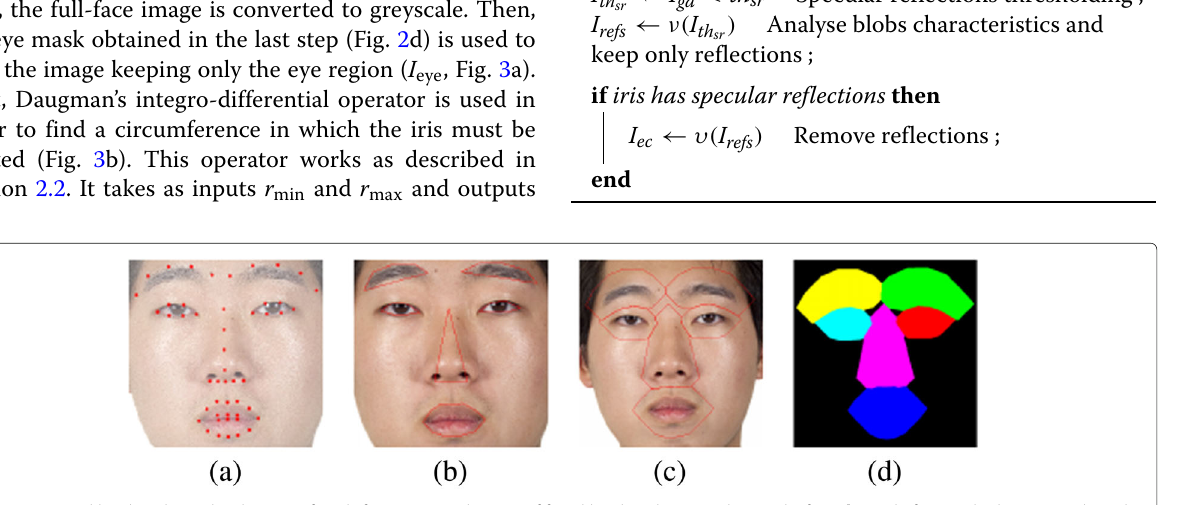
Fig. 2 Detected landmarks and polygons of each feature. Distribution of facial landmarks ( a ), polygons before ( b ) and after ( c ) thickening and masks used to extract the features ( d